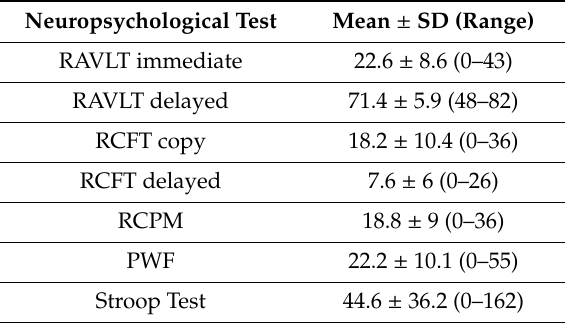
Table 2. A general overview of Neuropsychological tests results in the whole population: Rey auditory verbal learning test, immediate recall (RAVLT immediate); Rey auditory verbal learning test, delayed recall (RAVLT, delayed); Rey complex figure test, copy (RCFT, copy); Rey complex figure test, delayed recall (RCFT, delayed); Raven’s colored progressive matrices (RCPM); phonological word fluency test (PWF) and Stroop